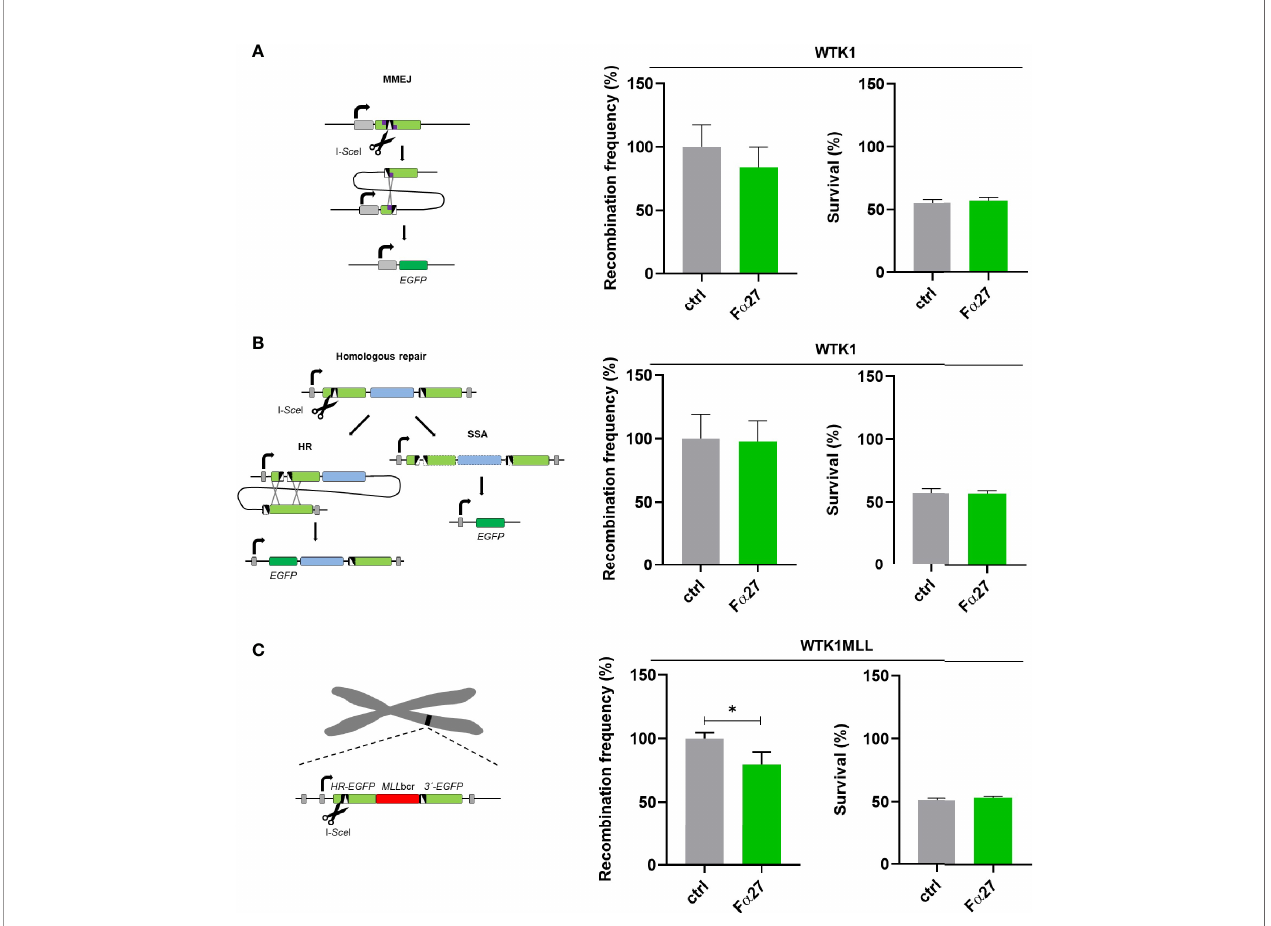
FIGURE 3 | In fl uence of F a 27 on I- Sce I-induced MMEJ and homologous repair. (A) Scheme and results of MMEJ analysis following repair substrate cleavage by I- Sce I. WTK1 cells were pre-treated with 1 mg/ml F a 27 for 4 h and then transfected with two plasmids, namely the repair construct for MMEJ and the I- Sce